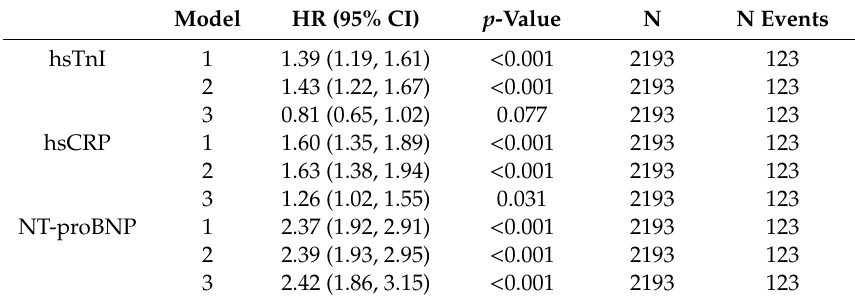
Model 1: adjusted for age and sex; Model 2: additionally adjusted for body-mass-index, diabetes, smoking status, dyslipidemia, and hypertension; Model 3: additionally adjusted for log(NT-proBNP) and log(hsCRP). Circulating biomarkers were used